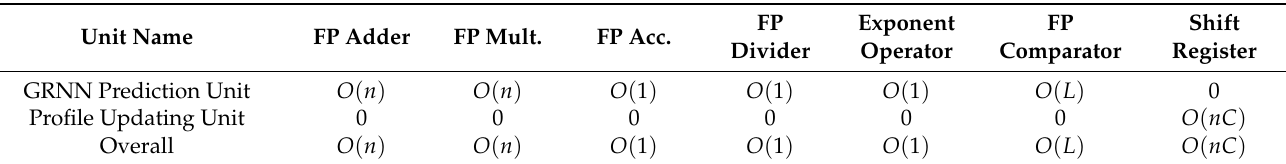
Table 3. Asymptotic analysis of number of arithmetic operators and the size of shift registers for the proposed FPGA